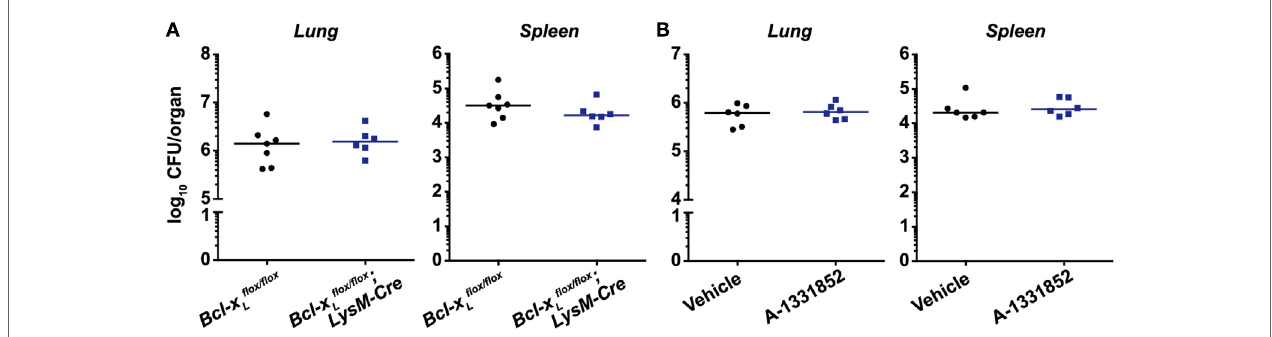
FigUre 3 | BCL-XL signaling does not contribute to Mycobacterium tuberculosis (Mtb) disease pathogenesis and is not a viable therapeutic target for Mtb infection. (a) Bacterial burden in the lungs and spleens of mice with a conditional deletion of Bcl-x L in myeloid cells 4 weeks post-infection with aerosolized Mtb ( n = 6–7 per genotype). (B) Bacterial burden in the lungs and spleens of mice treated with vehicle or 25 mg/kg of the BCL-XL-selective inhibitor A-1331852 on 10 days over a 2-week period, commencing 4 weeks post-infection ( n = 6 per treatment group). Graphs show median, and each point represents one mouse. There were no statistically significant differences between genotypes ( p >